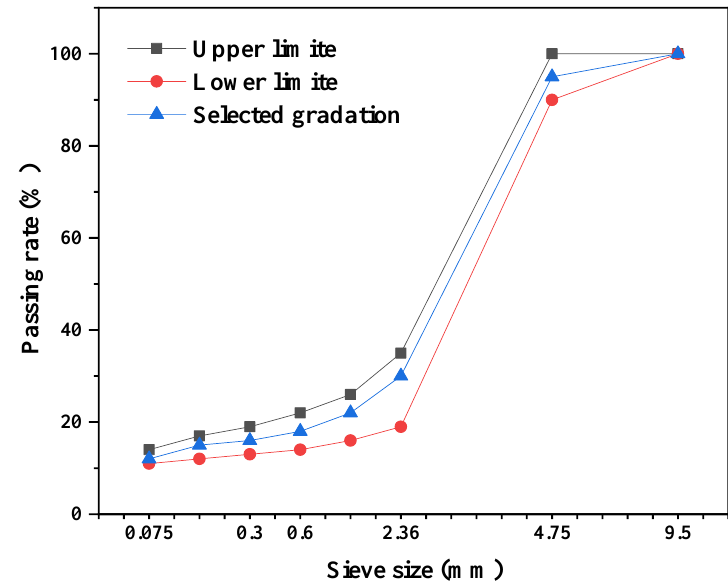
Figure 1. Gradation curve of asphalt mixture for the UML.